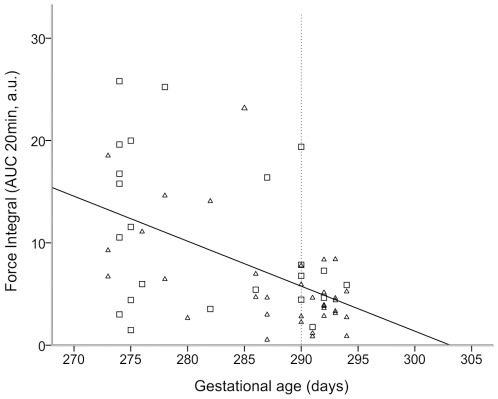
Myometrial contractility in relation to gestational age.Plot of spontaneous contractile activity (quantified as integral force of contraction/area under the contraction curve, AUC) of strips of myometrium obtained from women (n = 58) undergoing Caesarean section (CS) delivery against gestational age. Spearman's rank test found a significant negative correlation between force integral and gestational age (r = −0.478, P<0.01). Pre-labour CS women are denoted by open squares and CS in labour women are denoted by open triangles. Dotted vertical line indicates postdates delivery (≥41weeks+3 days).